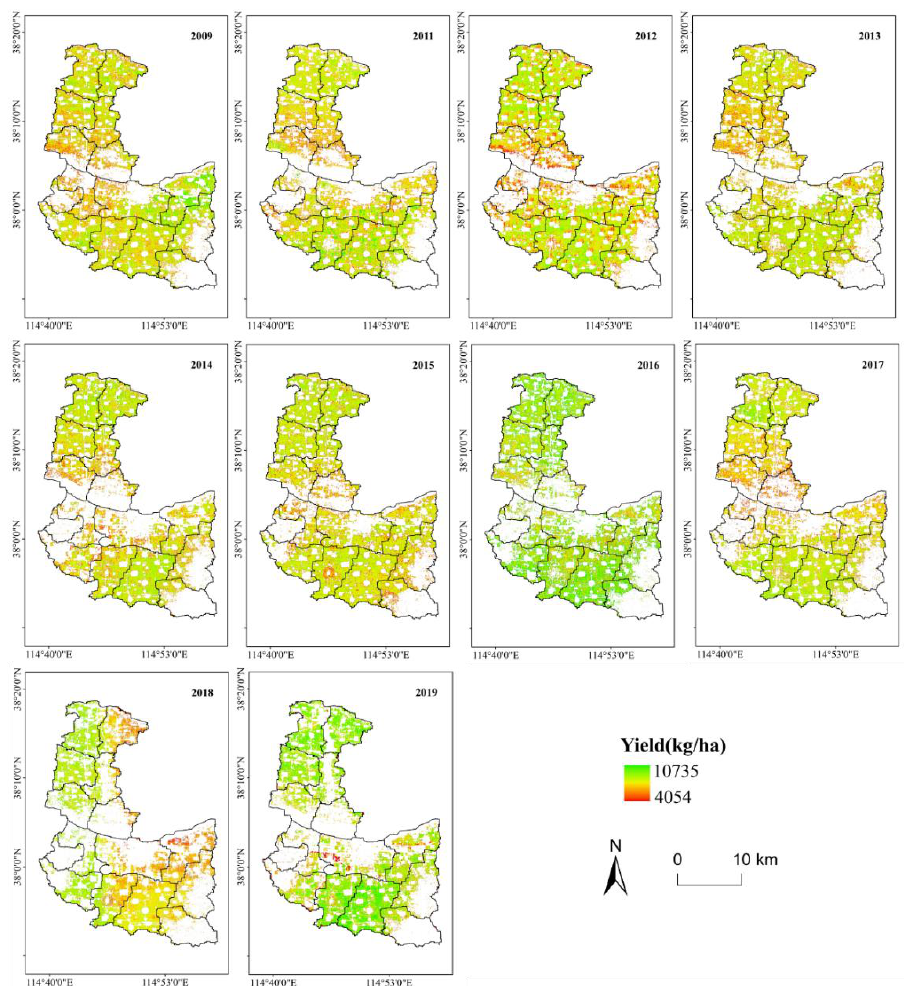
Figure 7. Distribution of unit yield of winter wheat in Gaocheng county from 2009 to 2019.